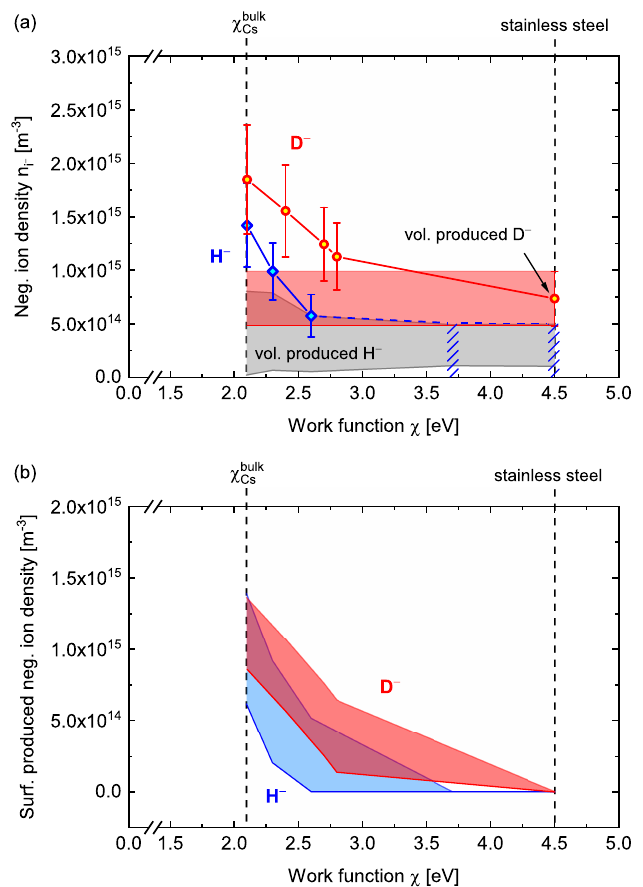
Figure 6. Comparison between deuterium (in red) and hydrogen (in blue). In ( a ), the negative ion density measured by CRDS is shown for different work functions. The expected volume produced negative ion density is illustrated in ( a ) as a grey shaded area for hydrogen (taken from Figure 4) and as a red shaded area for deuterium. In ( b ), the calculated negative ion densities coming from surface conversion are shown for different work functions for hydrogen (blue shaded area) and deuterium (red shaded area). These are given as ranges due to the uncertainty of the volume produced negative ion